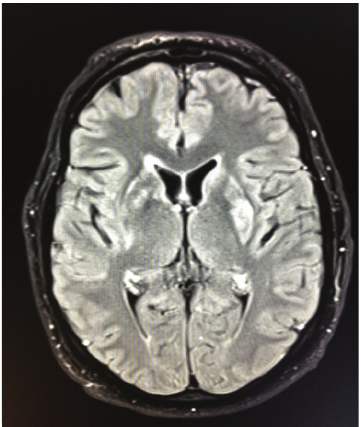
Figure4:AxialT2demonstrateshyperintensitywithintheleftputa- men.